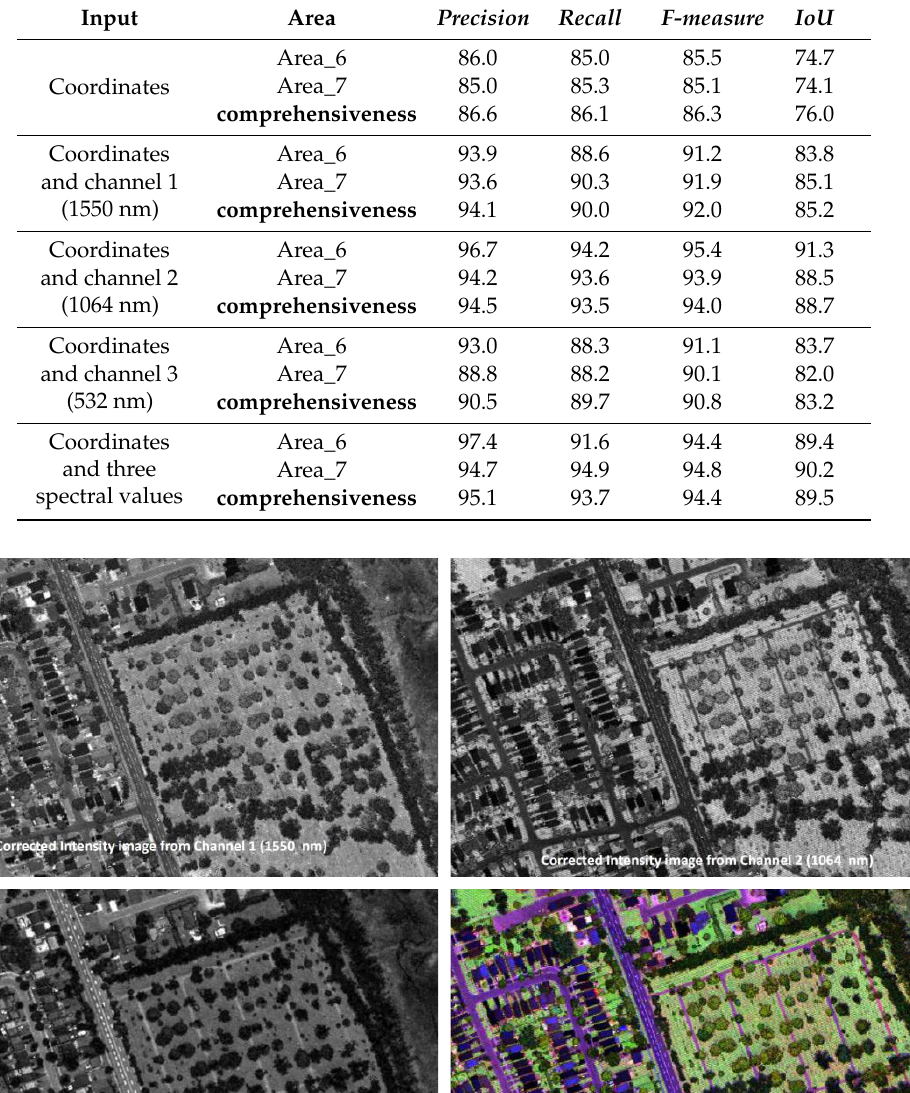
Table 4. A comparison between training with different sample sizes.